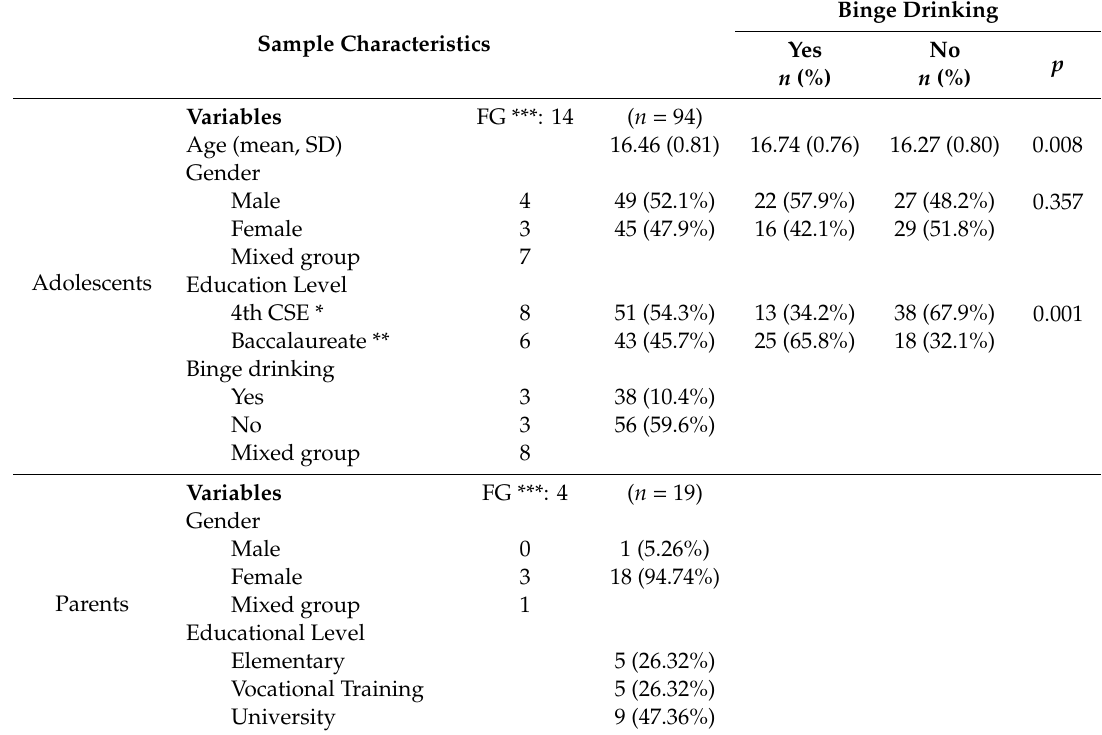
Table 1. Characteristics of adolescent participants in the focus group